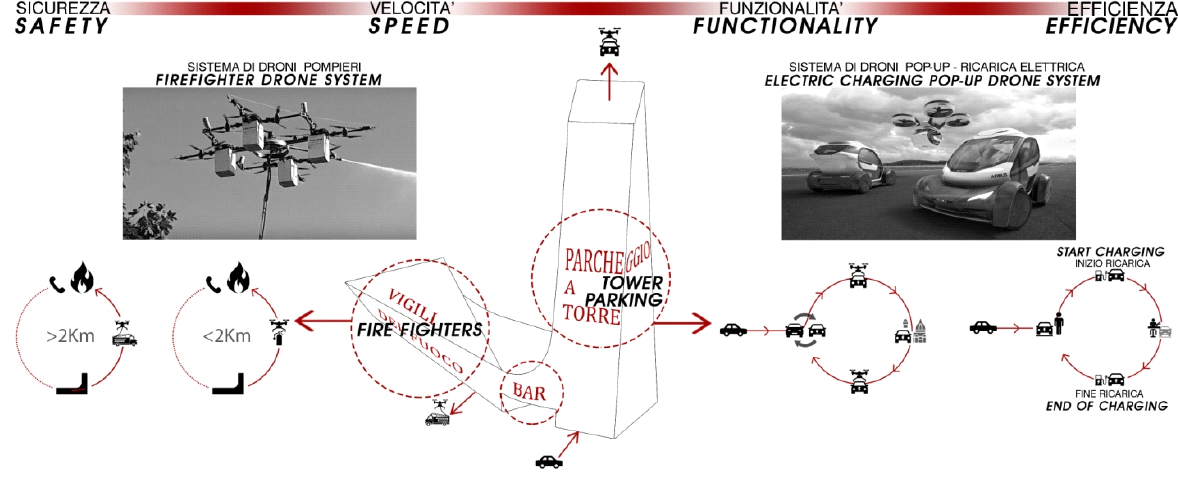
Figure 6 Simone Saporito, Florenze Smart City, Florence School of Architecture,